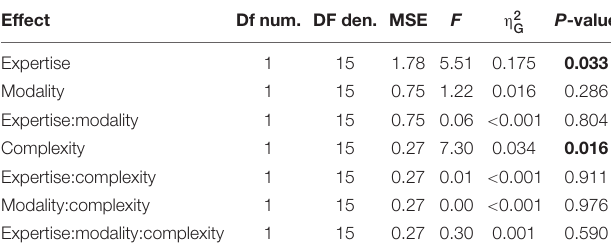
TABLE 2 | Repeated measure ANOVA—PSS (experiment